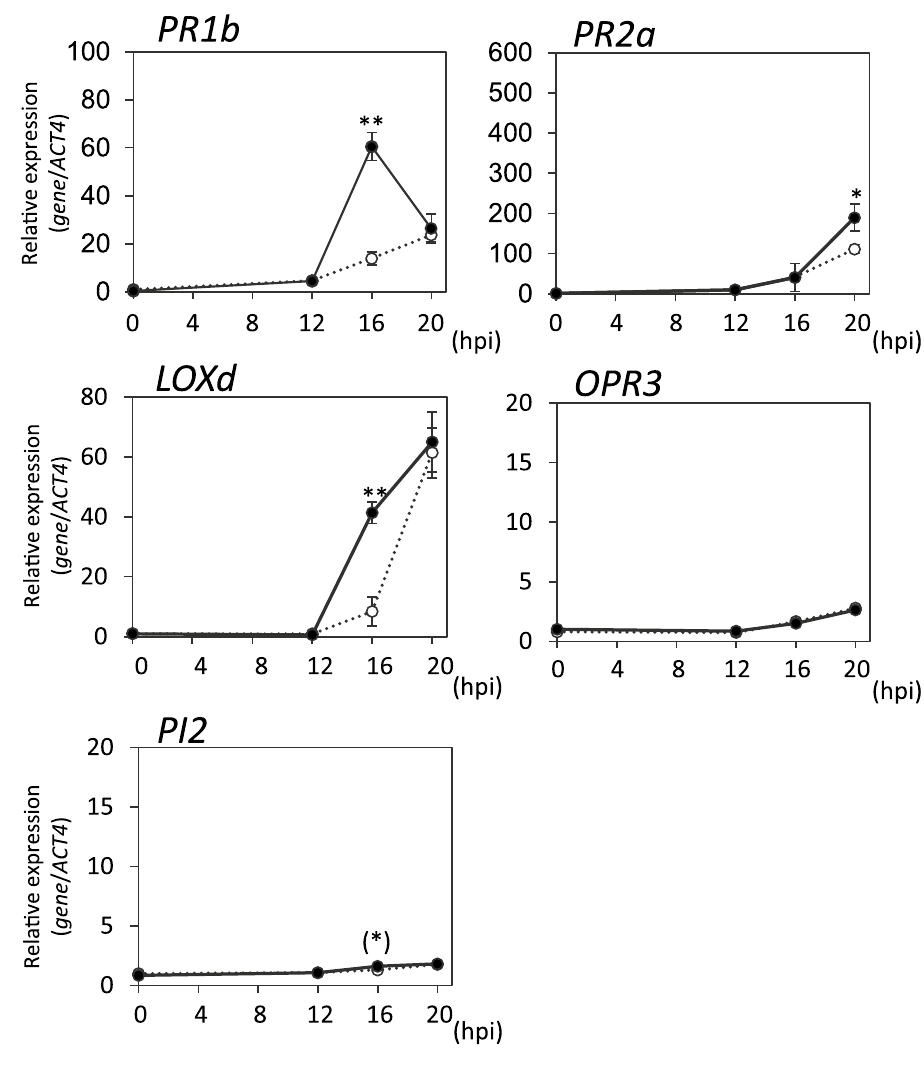
Figure 5. Expression of defense-related genes after infection with avirulent pathogen Pso. The G. margarita - colonized (14 days after G. margarita inoculation) and the water-treated control tomato plants were inoculated with Pso . Leaf disks were taken from the Pso -infiltrated part of the leaflets at the indicated time points (0, 12, 16, 20 h post inoculation (hpi)) and used for gene expression analyses of SA-related genes ( PR1b and PR2a ) and JA-related genes ( LOXd, OPR3 and PI2 ). Transcript levels were normalized to the expression of ACT4 measured in the same samples. The means and SEs were calculated from 4 independent samples, each prepared from a single plant. Open circle, water-treated control plant; closed circle, G. margarita -colonized plants. Asterisks indicate statistically significant difference between data of the water-treated control and G. margarita -colonized plants (two-sided t-test, **, p < 0.01; *, p < 0.05; (*) in PI2 , p = 0.061). The experiment was repeated three times with similar